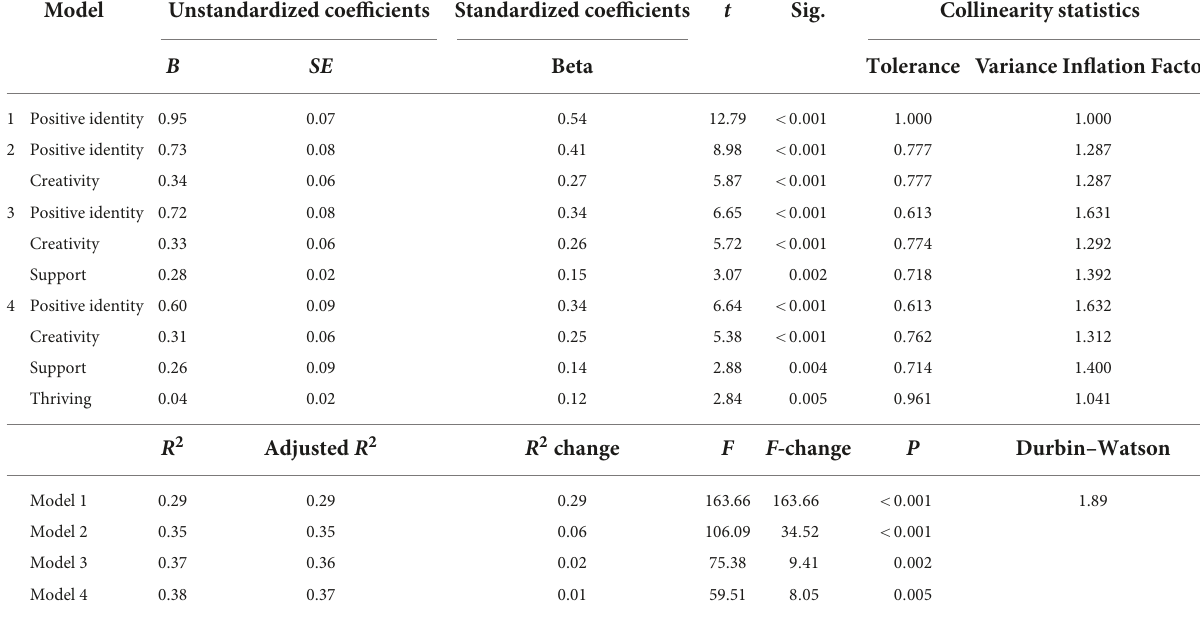
TABLE 4 Stepwise multiple linear regression models regarding the prediction of mental health ( n = 394).